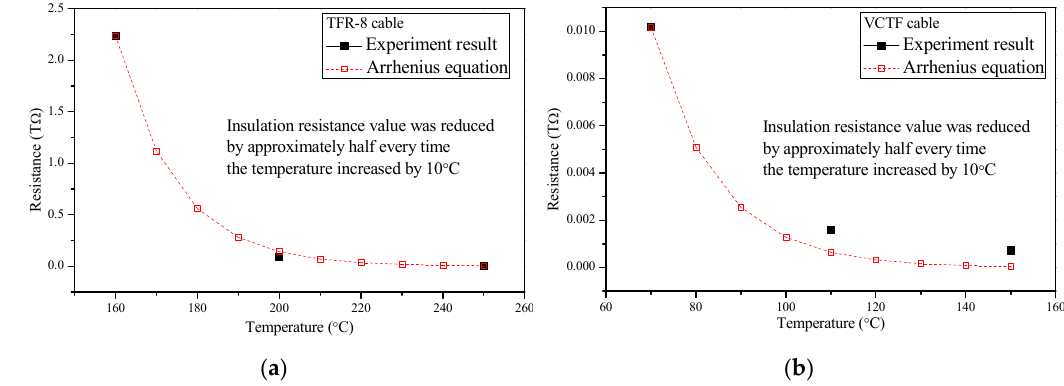
Figure 1. Comparison of the insulation resistance between the experimental result and the Arrhenius equation according to a temperature. ( a ) TFR-8 cable ( b ) VCTF cable.